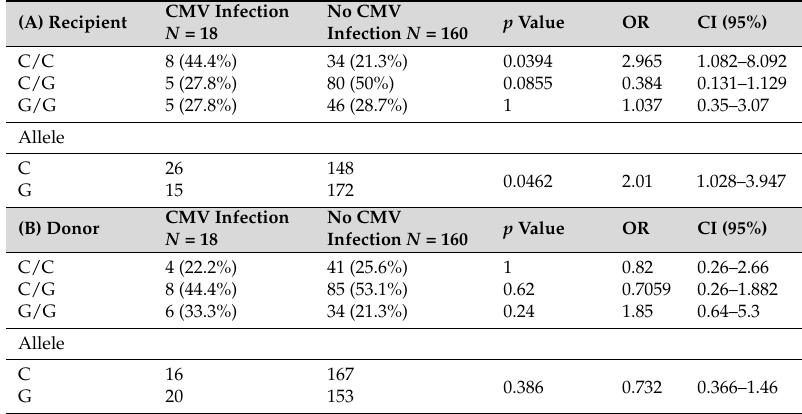
Table 1. The genotype distribution and allele frequencies of the +3142 C>G (rs1063320) gene polymorphism in living-donor kidney transplant recipients; ( A ) and corresponding donors ( B ) with respect to cytomegalovirus (CMV)